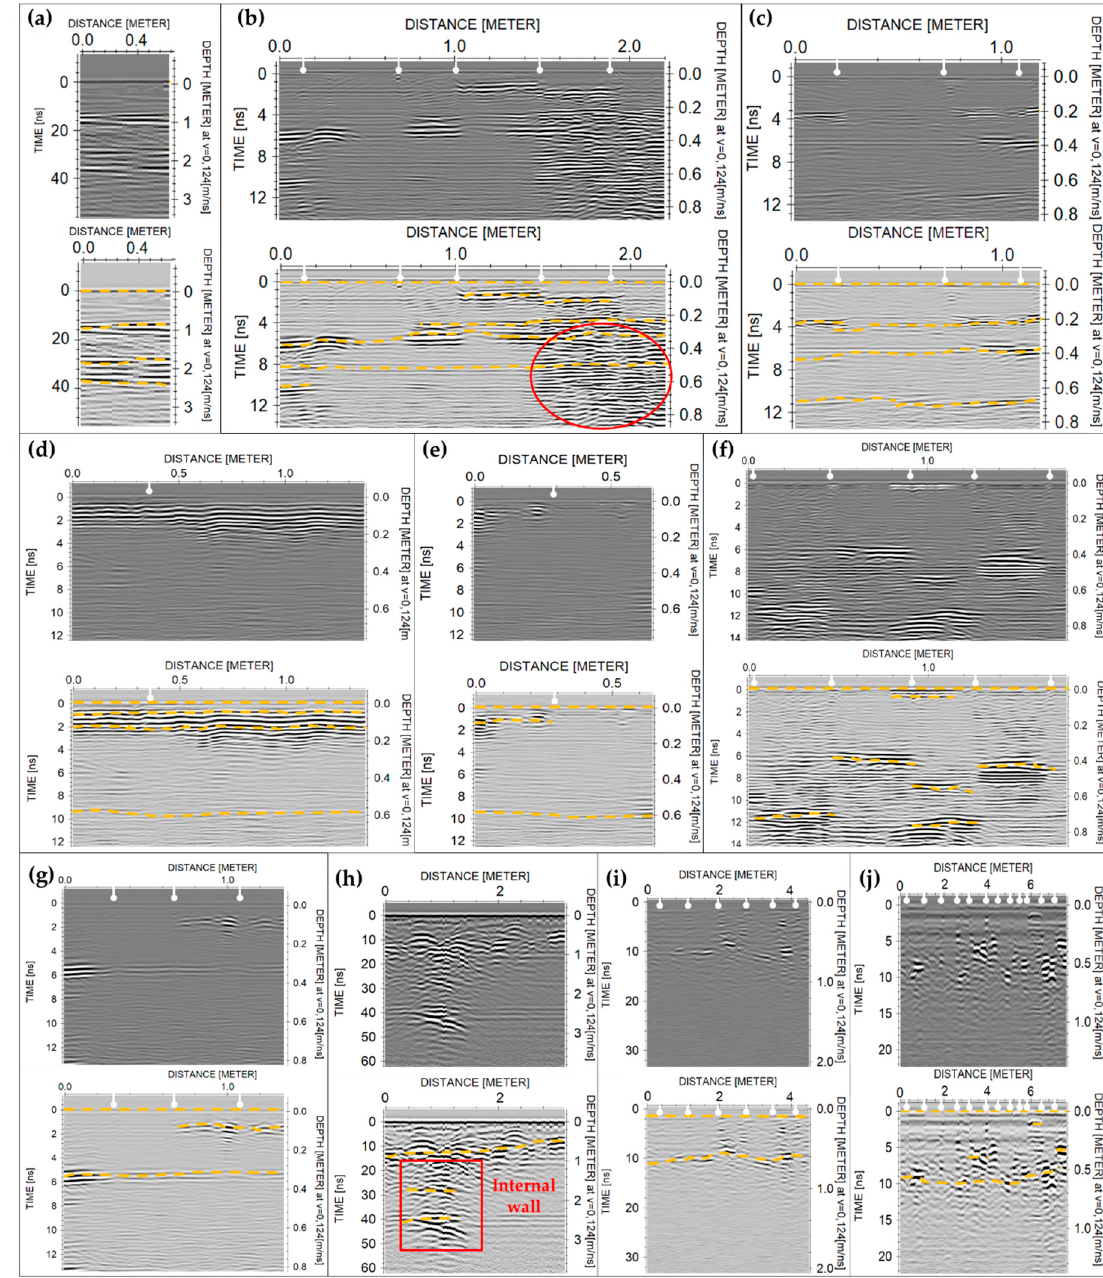
Figure 8. GPR data produced on the main façade of MB: ( a ) 500 MHz data in Zone 1, ( b ) 2300 MHz data in Zone 2.1, ( c ) 2300 MHz data in Zone 2.2, ( d ) 2300 MHz data in Zone 3.1, ( e ) 2300 MHz data in Zone 3.2, ( f ) 2300 MHz data in Zone 4, ( g ) 2300 MHz data in Zone 5, ( h ) 500 MHz data in Zone 6, ( i ) 800 MHz data in Zone 7, ( j ) 800 MHz data in Zone 8. (Vertical white marks are the field marks used for data integration, which corresponds to the separation of successive external stone blocks, while horizontal yellow dashed lines indicate the separation of successive internal stone blocks.).